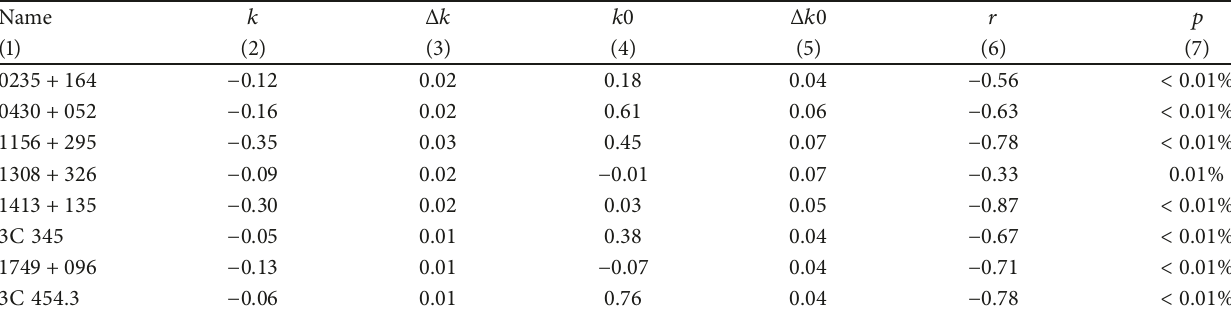
Table 2: The linear correlations between the spectral indices and flux densities.